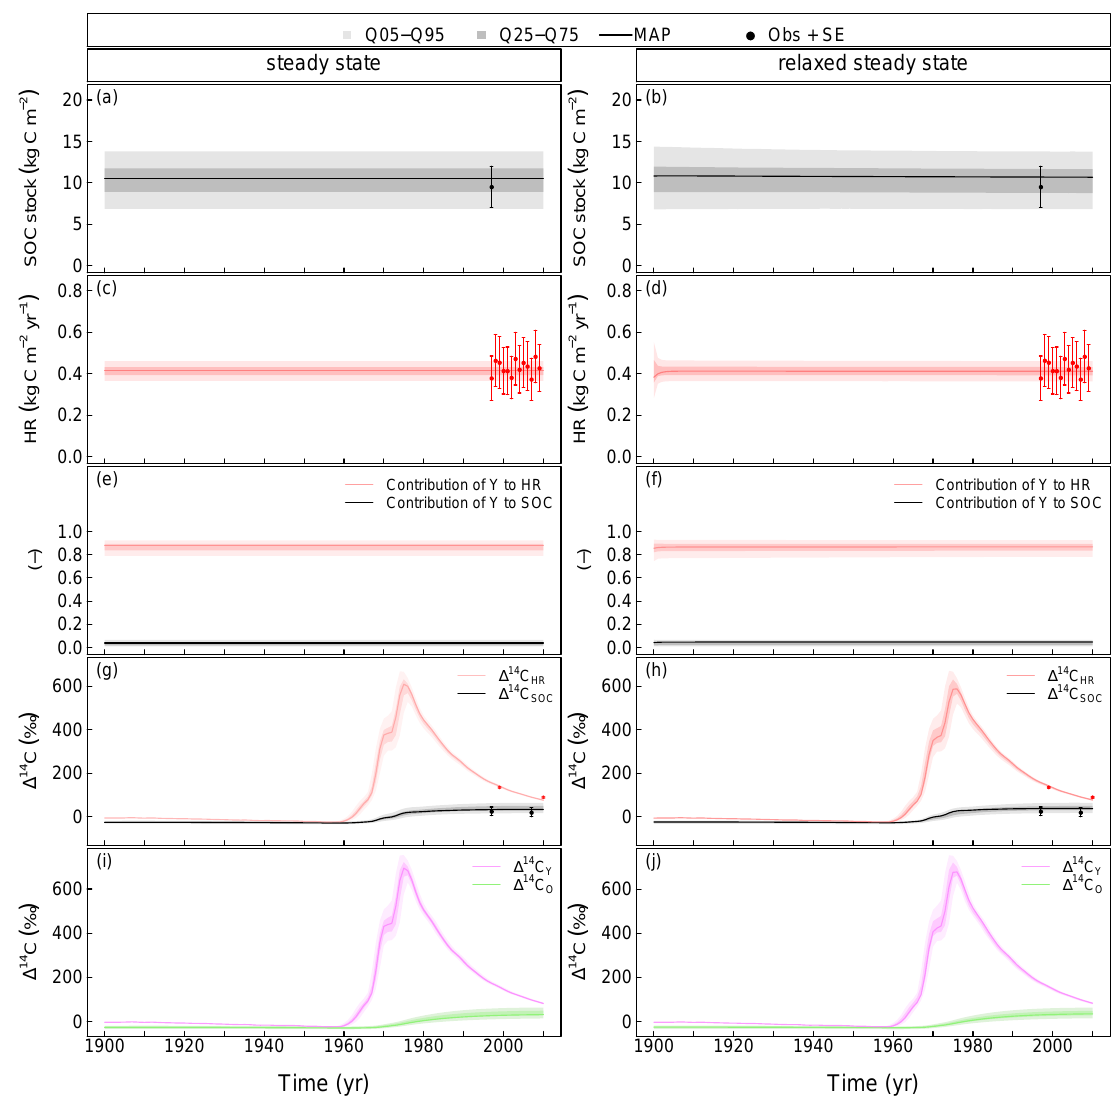
Fig. 7. Posterior predictive uncertainty of several output variables of the I 14 CBM at the Howland Tower site. Left column: results of a usual steady-state calibration using all observational constraints Run(+HR). Right column: results of a nonsteady-state calibration using all observational constraints Run(+HR). The solid lines display the maximum a posteriori (MAP) prediction of the respective variable. The shaded bands show the 25% and 75% quantile (Q25 and Q75) of the respective variable. The slightly lighter bands show the 5% and 95% quantile (Q05 and Q95) of the predictive uncertainty. The gradient of shading is valid for all color codes. Circles with error bars denote the data values ± standard error (Obs ±